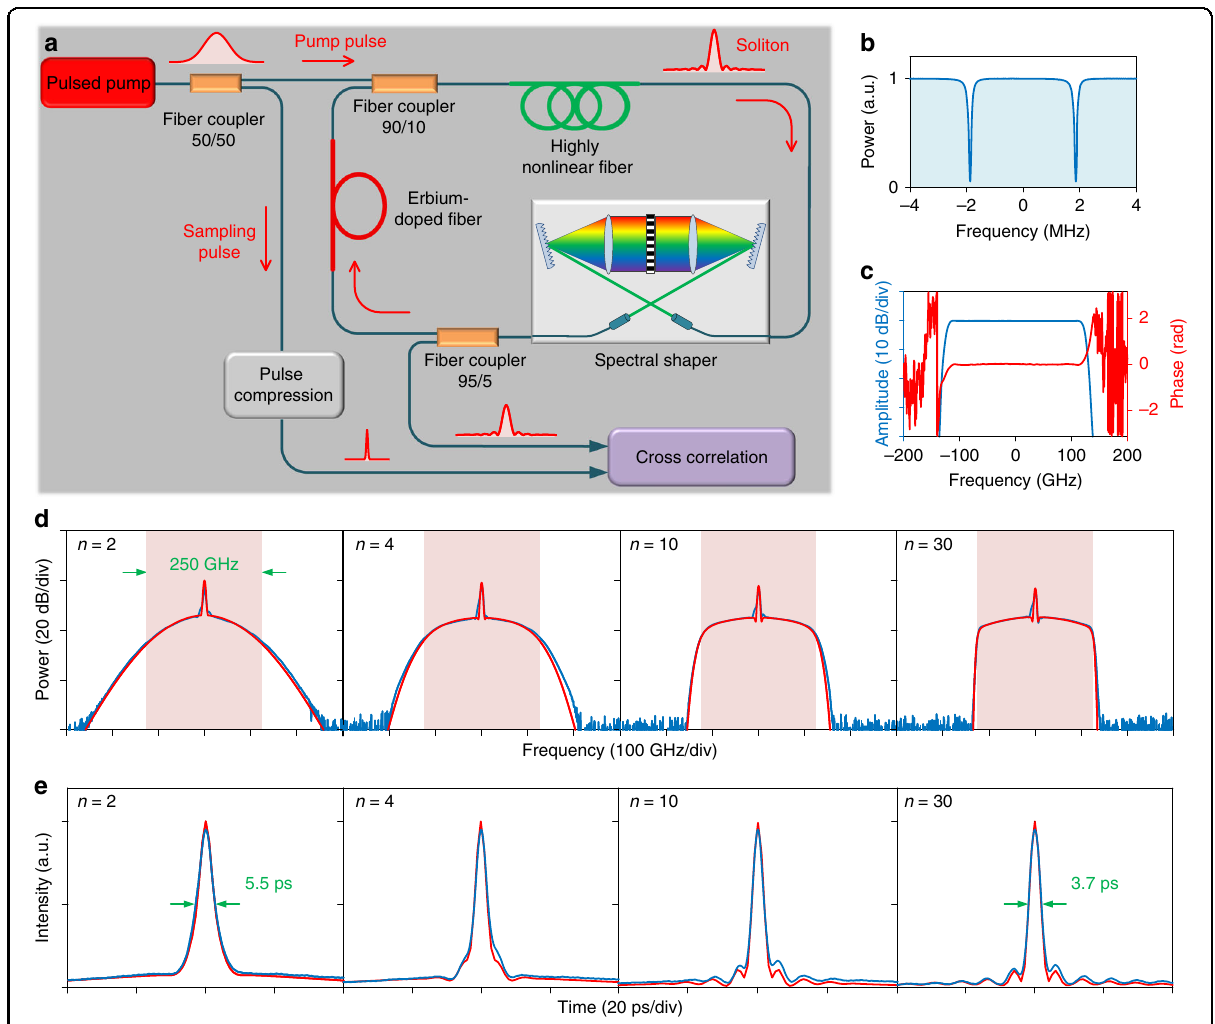
Fig. 2 Observation of dispersion-less cavity solitons. a Experimental set-up. A spectral shaper is inserted in the cavity for programmable dispersion and fi lter control. The cavity is synchronously pumped by a sequence of sub-nanosecond Gaussian pulses for soliton generation. b Through-port response of the cavity measured with a low-power continuous-wave laser. c Roundtrip transfer function of the cavity when the spectral shaper is programmed to a gate bandpass fi lter and the fi ber group velocity dispersion is compensated. d , e Optical spectrum and temporal intensity waveform of the dispersion-less cavity solitons. Blue, measured; red, simulated. The fi lter bandwidth is 250 GHz, and the fi lter order n = 2, 4, 10 and 30, respectively. With the increase of fi lter order, the soliton spectrum becomes more con fi ned in the 250-GHz frequency window (brown region), and the soliton waveform tends to become a Nyquist pulse. The pulse width (FWHM) is 5.5 ps and the estimated chirp parameter is 1 when n = 2. The Nyquist soliton when n = 30 is nearly chirp-free with a width of 3.7